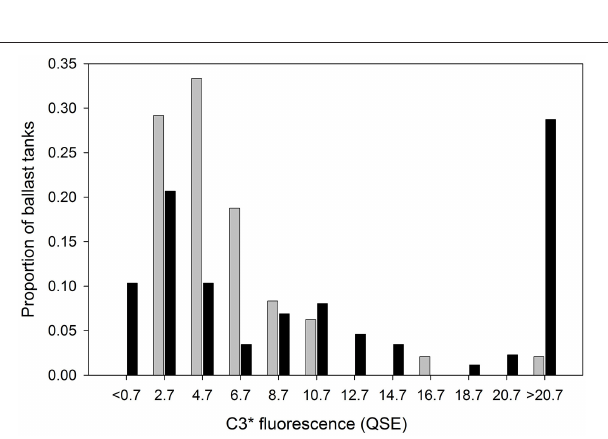
FIGURE 3 | C3 * distribution in randomly sampled unexchanged ballast tanks in this study ( n = 48 , dark bars) compared with expected pre-BWE C3 * if ballast water exchange were reported correctly ( n = 79 , light bars).